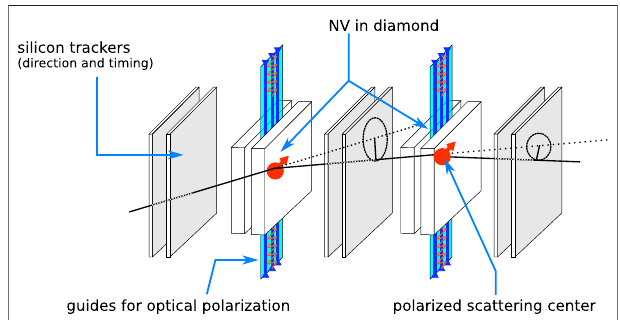
FIGURE 3 | Conceptual scheme of a charged particle tracked with incorporated polarimeter based on NV ’ s in diamond as polarizable scattering medium. The polarization is measured particle-by-particle by using the right- left asymmetry in the scattering probabilities. Two planes of tracking detectors, such as silicon pixel or microstrip detectors, are needed to determinetheparticledirectionbeforeandafterthepolarizedscatteringplane. The polarization of the diamonds can be achieved using optical means.